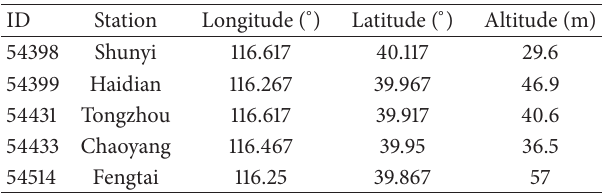
Table 3: The locations and altitudes of the meteorological stations given in Figure